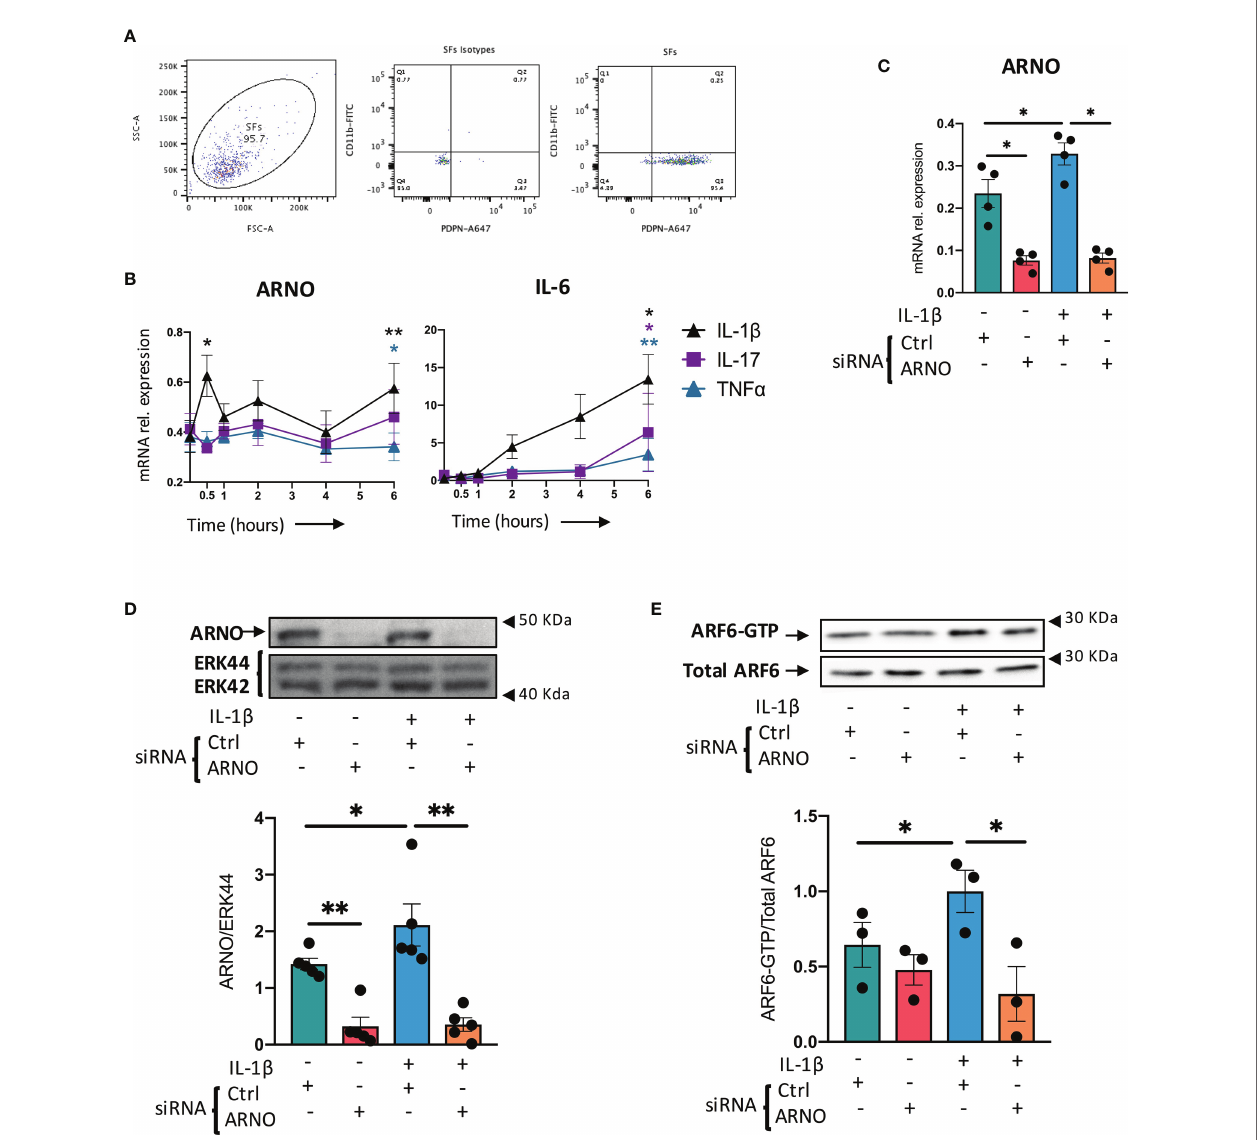
FIGURE 1 | IL-1 b upregulates ARNO in SFs. (A) SFs were isolated from mouse synovium and expanded ex vivo . Cells were trypsinased and expression of podoplanin (PDPN) and CD11b was evaluated by fl ow cytometry. (B) SFs were stimulated with IL-1 b , IL-17 and TNF a (10 ng/ml) for 30 minutes and 1, 2, 4 and 6 hours, when RNA was extracted. Expression of ARNO and IL-6 mRNA was then quanti fi ed by RT-qPCR. Data show the mean of at least three independent experiments (analysed in technical triplicates) ± SEM. (C) Naïve SFs were transfected with either ARNO or control Allstars siRNA, followed by stimulation with recombinant IL-1 b (10 ng/ml) when indicated. RNA was extracted after 6 hours and ARNO mRNA expression was evaluated by RT-qPCR. Each dot represents an independent experiment (analysed in technical triplicate), and error bars represent SEM. (D) SFs were transfected and stimulated as in (C) , and proteins were extracted 24h after stimulation. ARNO protein was detected by speci fi c monoclonal antibodies by Western bloting and total Erk was used as loading control. Image shows one representative experiment. Column graph shows quanti fi cation of band intensity for ARNO normalised to Erk44. (E) SFs treated with Allstars or ARNO siRNA followed by IL-1 b stimulation (5 minutes) were assayed by ARF6-GTP pull down assay and subsequently immunoblotted with anti-ARF6 antibody. Relative activation of ARF6 was normalised to unstimulated control siRNA-treated samples. For (D, E) , each dot represents an independent experiment and error bars represent SEM. *p < 0.05, **p < 0.01 by Wilcoxon ’ s matched-paired signed rank test in (B) , by Mann-Whitney test in (C – E)